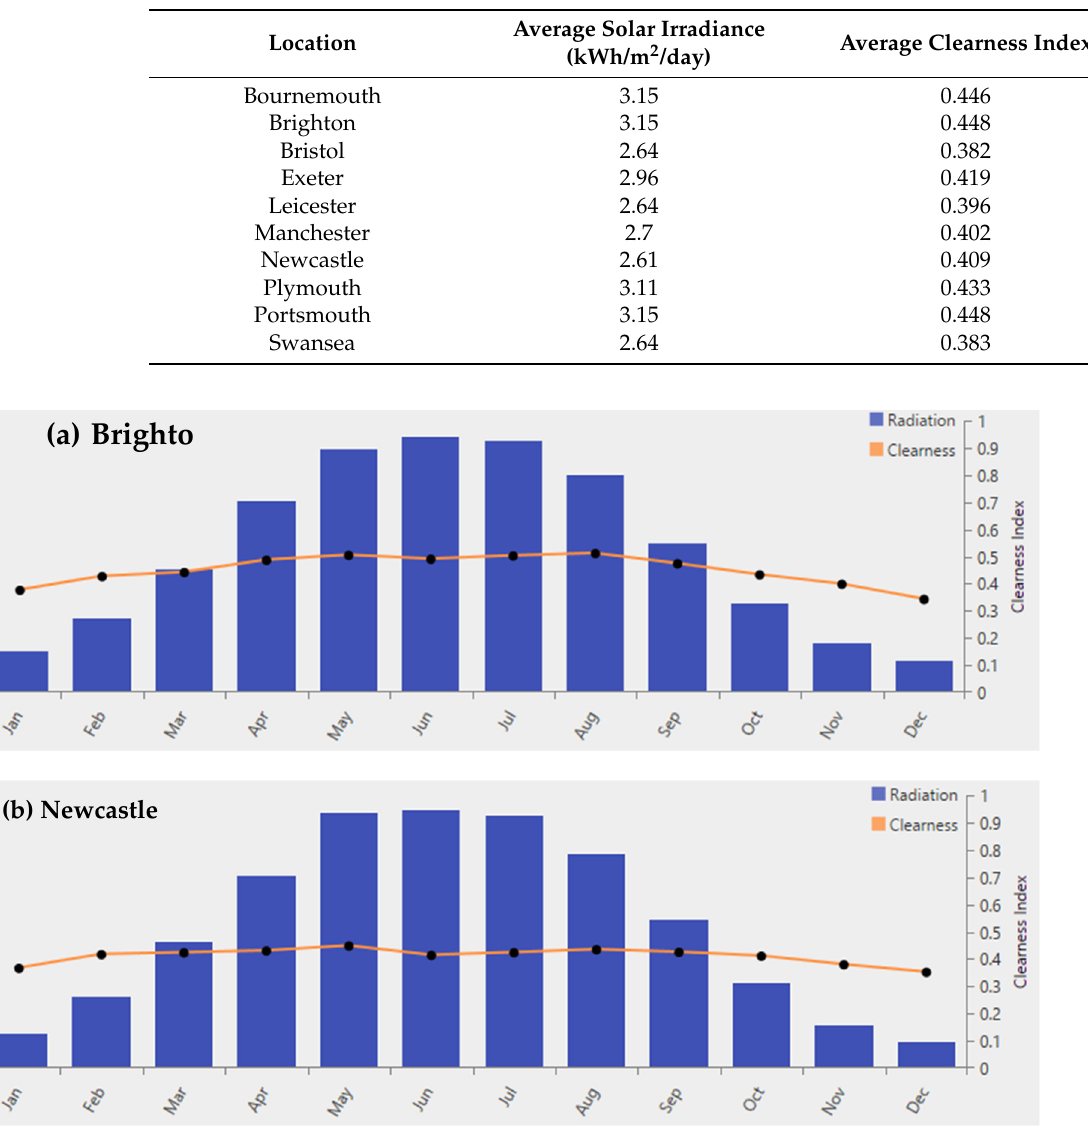
Figure 4. Monthly solar GHI resource for ( a ) Brighton and ( b ) Newcastle.